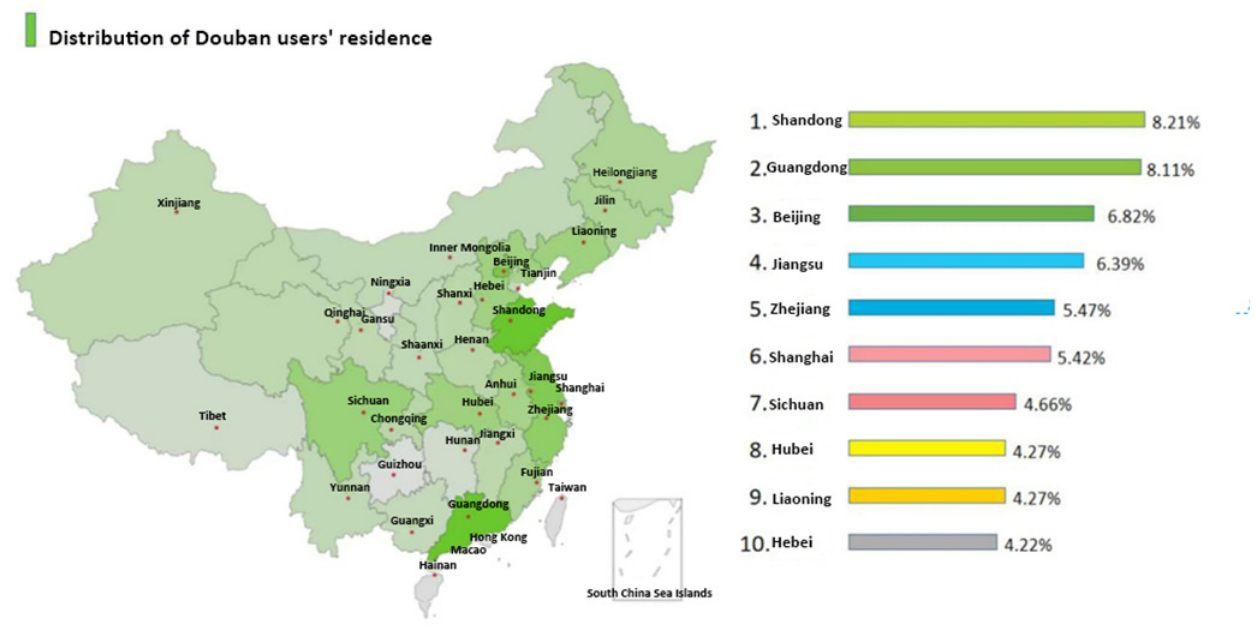
Figure 2. Residence statistics of Douban users 3 .